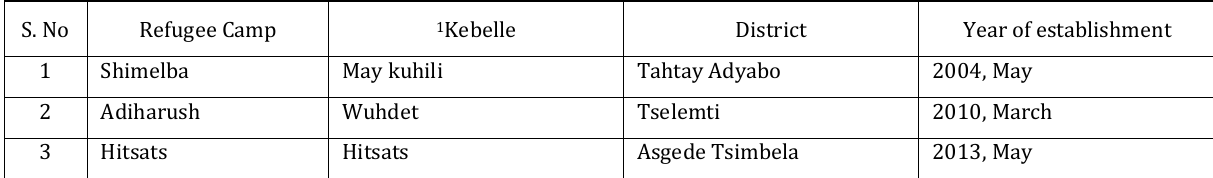
Table 1. Refugee camps under study and their year of